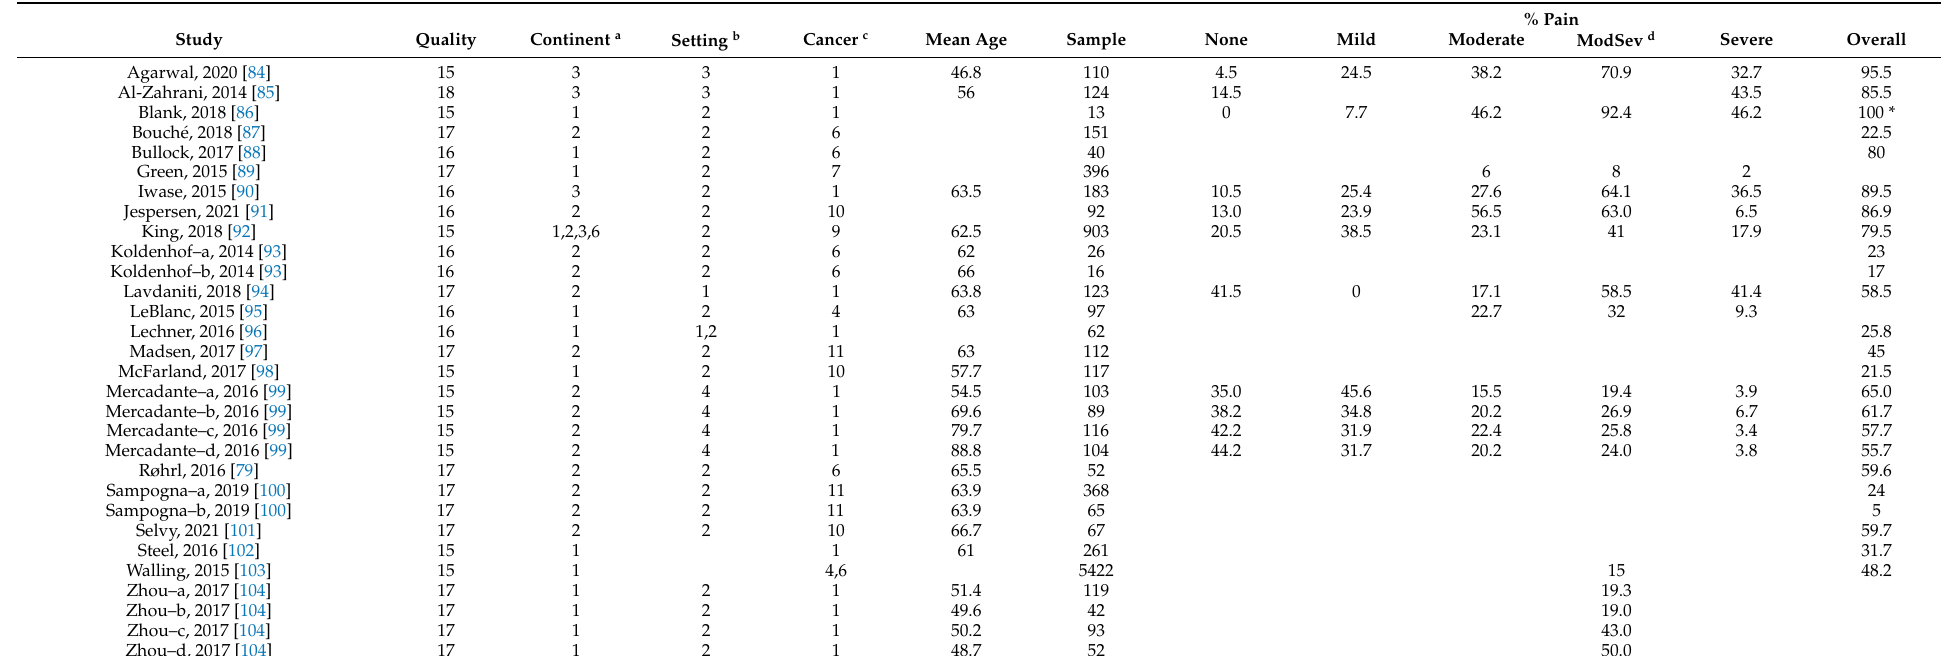
Table 4. Pain prevalence in patients with palliative treatment (Group 3) ( n = 22).